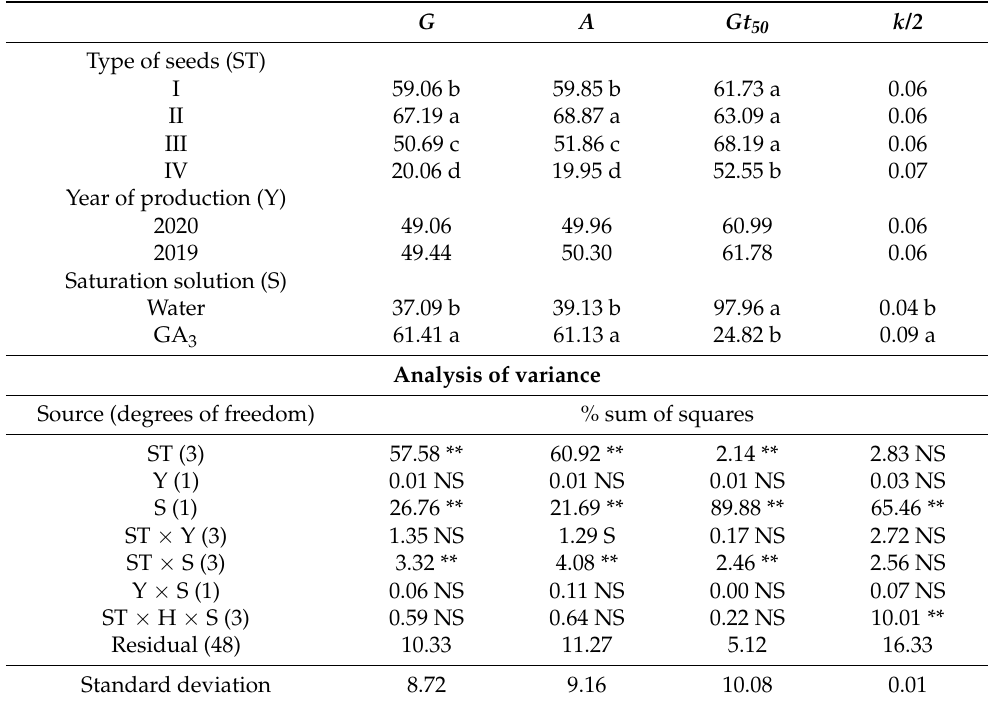
Table 4. Effects of the type of seeds, the year of production, and the substrate saturation solution on the germination parameters: cumulative germination ( G , %), final germination percentage ( A , %), time (d) required to reach 50% of final germination ( Gt 50 ), and average germination rate ( k /2; d − 1 ); mean